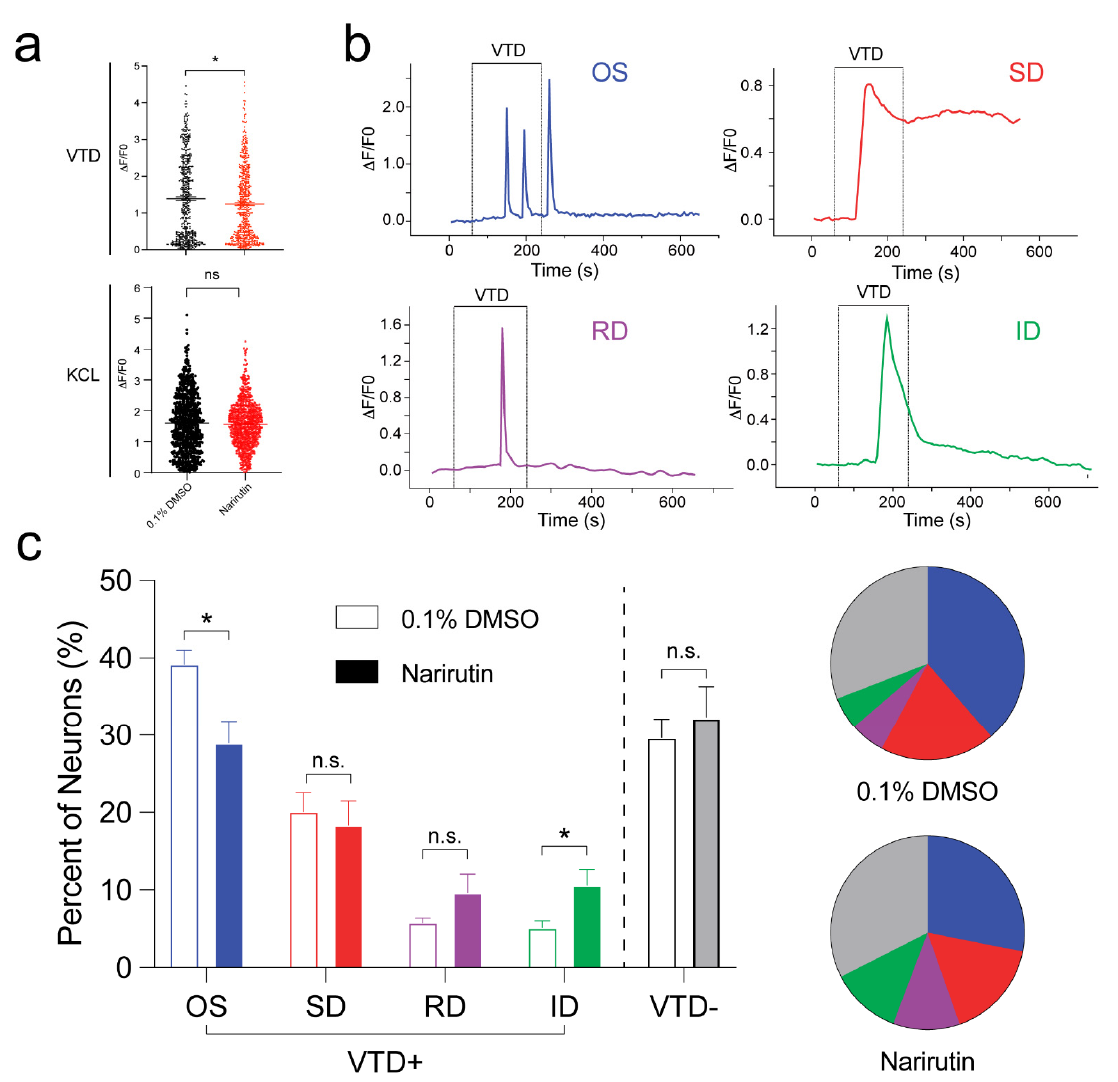
Figure 2. Narirutin inhibited Veratridine-triggered nociceptor activities of DRG neurons. ( a ) Peak Ca 2+ responses of DRG neurons induced by Veratridine (up) or KCL (down) with 0.1% DMSO or 20 μ M Narirutin overnight incubation (0.1% DMSO, n = 5 slices; Narirutin, n = 4 slices). ( b ) Representa- tive traces of the four response profiles triggered by Veratridine: oscillatory (OS, blue), slow decay (SD, red), rapid decay (RD, purple), and intermediate decay (ID, green) profile. ( c ) Percentage of different populations of DRG neurons based on the Veratridine-response pattern after being treated with 0.1% DMSO or 20 μ M Narirutin overnight incubation. Pie charts represent mean values in the histogram (0.1% DMSO, n = 5 slices; Narirutin, n = 4 slices). Data are expressed as means ± SEM. Asterisks indicate statistical significance compared with vehicle treatment (* p < 0.05, unpaired two- tailed Student’s t -test and two-way ANOVA with Sidak’s post hoc test).